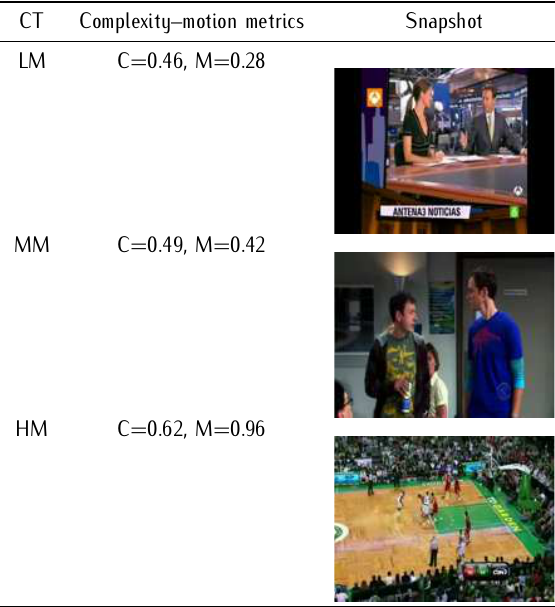
Table 1. Complexity–motion metrics and snapshot of videos